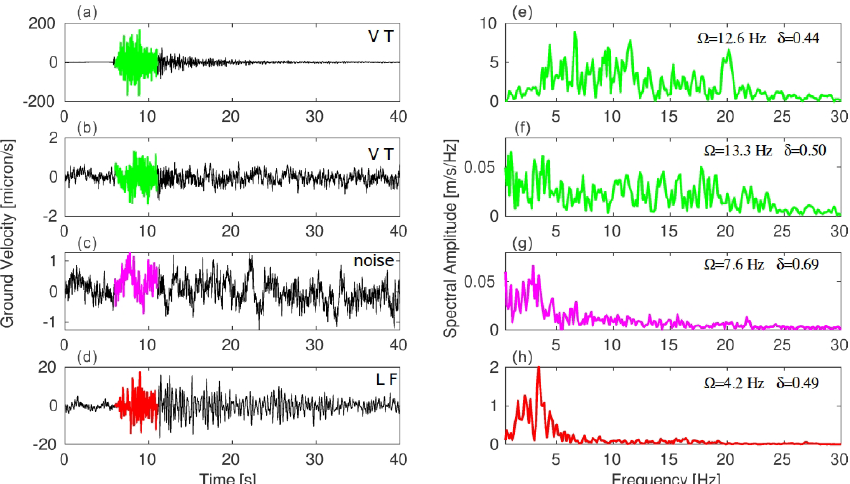
Figure 3. Local seismic events recoded at BKSG station (left, Z component) and their amplitude spectra (right). From top to bottom 2VT earthquakes (2018-10-16 01:07:09 M D 2.5, 2018-01-29 17:32:58 M D 0.3, green), seismic noise (magenta) and LF event (red) are shown. The green, magenta and red time windows (left side) indicate the signal used for amplitude spectrum evaluation (right side). In the upper-right corners of the amplitude spectra figures, the corresponding values of central frequency and shape factor are shown. Table 1. Spectral parameters range for VT and LF events evaluated for all the selected stations. VT events LF events Stations Central frequency Shape factor δ Central frequency Shape factor δ (cid:127) (Hz) (cid:127) (Hz)